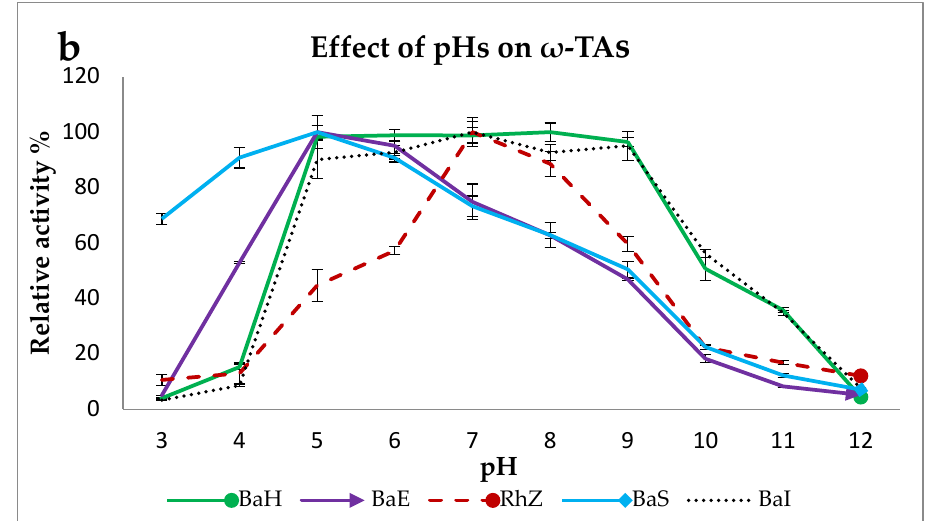
Figure 1. The effect of temperature ( a ) and pH ( b ) on the amination of pyruvate and ( S )-MBA as amino donor using 1 mg/mL of cell-free extracts of screened strains: Bacillus halotolerans (BaH), Bacillus endophyticus (BaE), Rhizobium radiobacter (RhZ), Bacillus subtilis subsp. s tercoris (BaS) and Bacillus subtilis subsp. i naquosorum (BaI).Reaction conditions are given in the method section. Formation of acetophenone was detected by HPLC at 254 nm. The value of 100% corresponded to the highest activity. Error bars represent ± standard deviation.